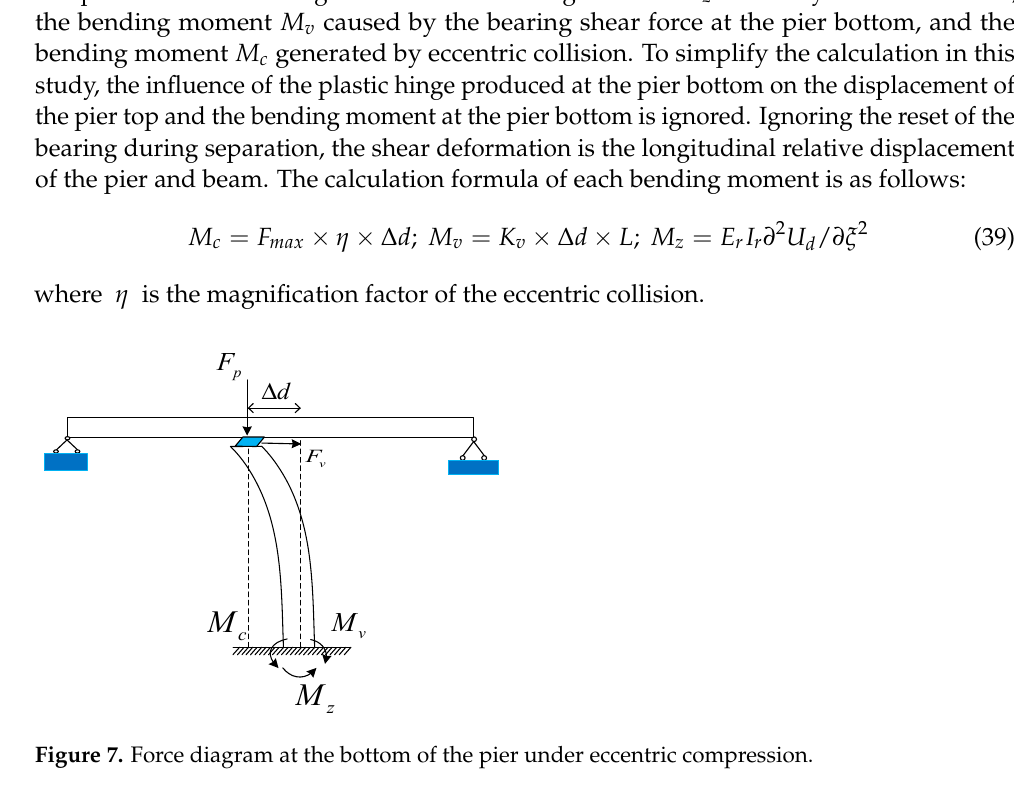
Figure 6. Bending moment change of bridge pier under two conditions: ( left ) Vibration bending moment; ( right ) Eccentric compression moment.